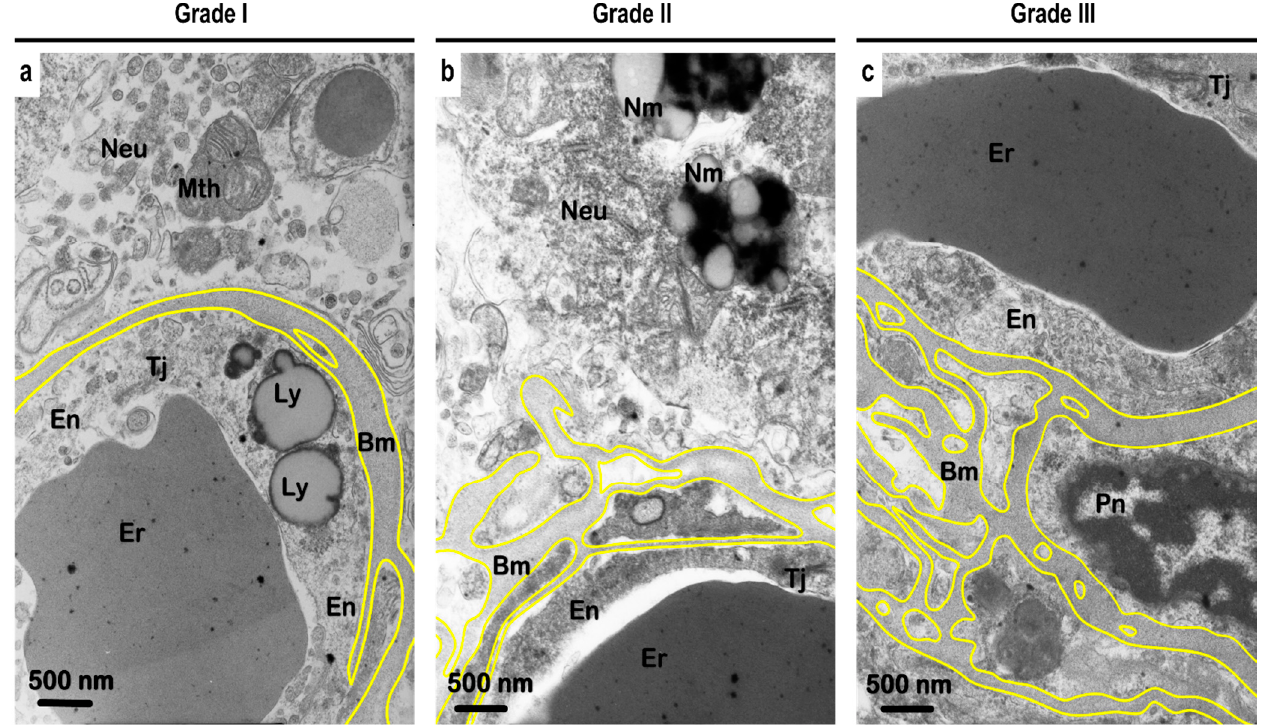
Figure 6. Representative transmission electron microscopy (TEM) micrographs of ultrastructural changes observed in different grades of blood vessels in the gray matter of predominantly ( a ) controls and ( b , c ) alcoholics. The yellow lines indicate the outer borderline of the basement membrane (Bm). ( a ) Accumulation of lipolysosomes in the cytoplasm of the endothelial cell. Homogenous and smooth BM can be seen. ( b ) Endothelial cells with tight junctions and nearby neuron containing neuromelanin is seen. The vessel has a lamellar BM. ( c ) Endothelial cells with tight junctions and pericyte with nucleus can be seen. The vessel shows splitting of the BM. Abbreviations: Neu, neuron; Er, erythrocyte; Pn, nucleus of pericyte; En, endothelial cell; Tj, tight junction; Mth, mitochondria; Nm, neuromelanin; Ly, lipolysosomes. Original magnification, 12,000×. Scale bars, 500 nm.